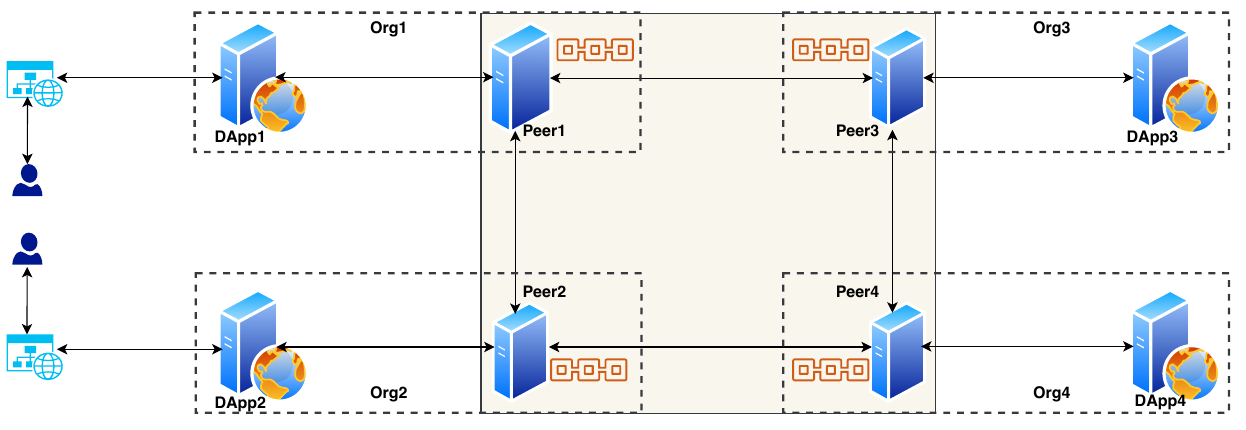
Figure 2. Fabric